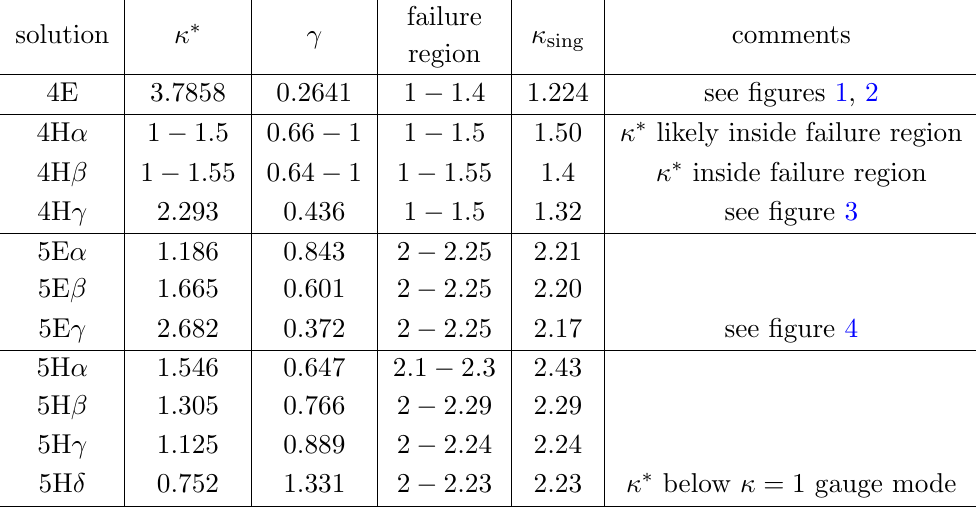
Table 1 . Results for the Choptuik exponents of the self-similar